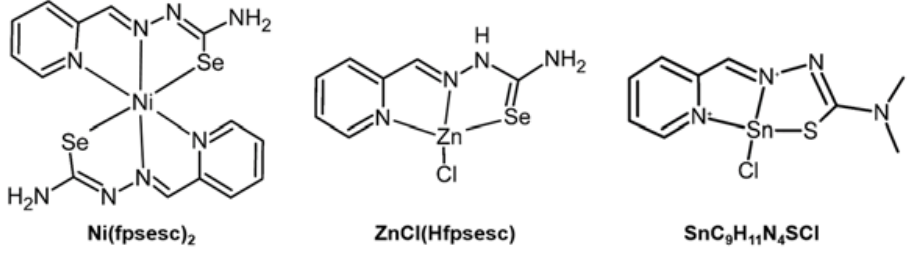
Figure 10. Ni(II)-, Zn(II)-, and Sn(II)-complexes regulating the activity and expression of Figure 10. Ni(II) ‐ , Zn(II) ‐ , and Sn(II) ‐ complexes regulating the activity and expression of MMPs.